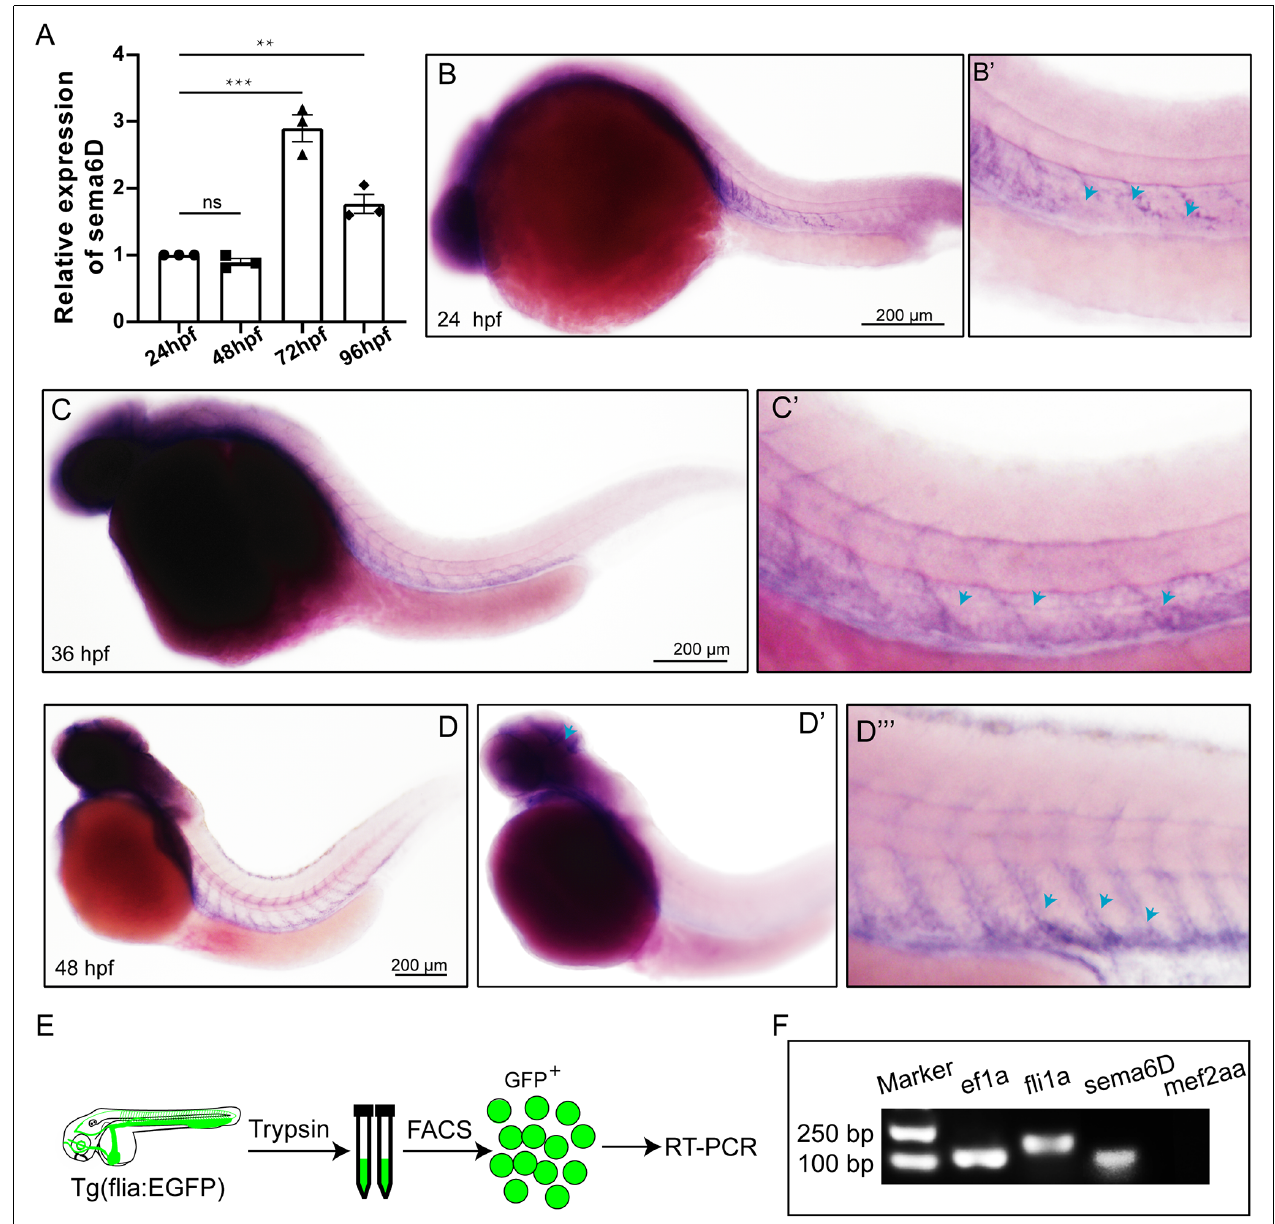
FIGURE 2 | Expression of sema6D gene in embryonic zebrafish at different stages. (A) QRT-PCR analysis of sema6D expression in embryonic zebrafish at different stages ( n = 3). One-way ANOVA, values with ** and *** above the bars are significantly different ( P < 0.01 and P < 0.001, respectively); value with “ns” above the bars indicated no significantly different. (B–D) Whole mount in situ hybridization analysis of sema6D in zebrafish embryos at different stages, blue arrowheads indicate blood vessels. (E) The procedure of the endothelial cells sorting and RT-PCR. (F) The agarose gel electrophoresis results of RT-PCR on fli1a-EGFP sorted